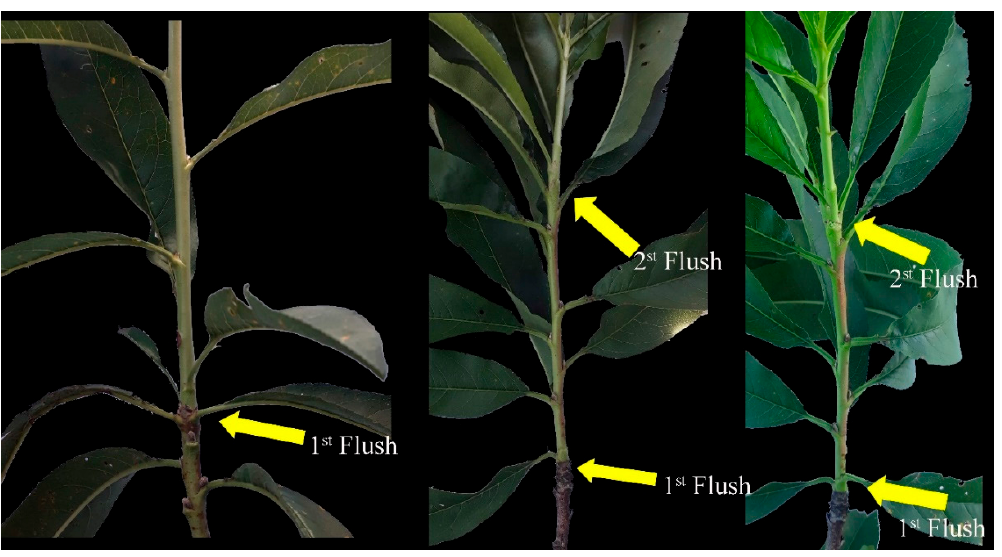
Figure 4. The arrows indicate occurrence of plant growth flushes after fruit harvesting grown in a tropical climate region, Minas Gerais State, Brazil.